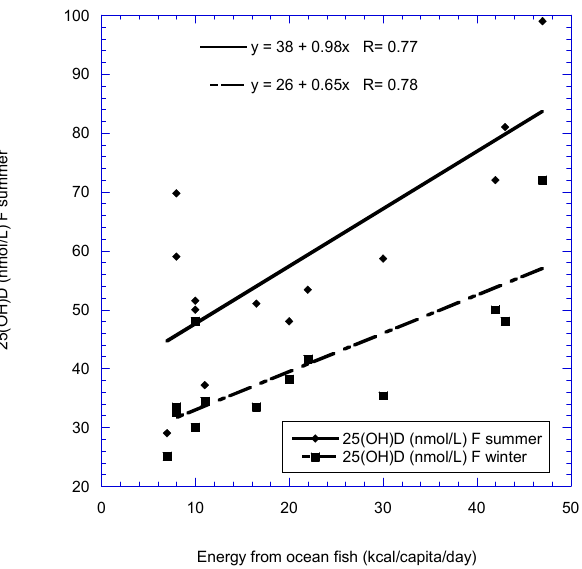
Figure 1. Serum 25(OH)D concentrations for females in 11 countries vs. energy supply from ocean fish (Portugal is omitted) (Table 2).